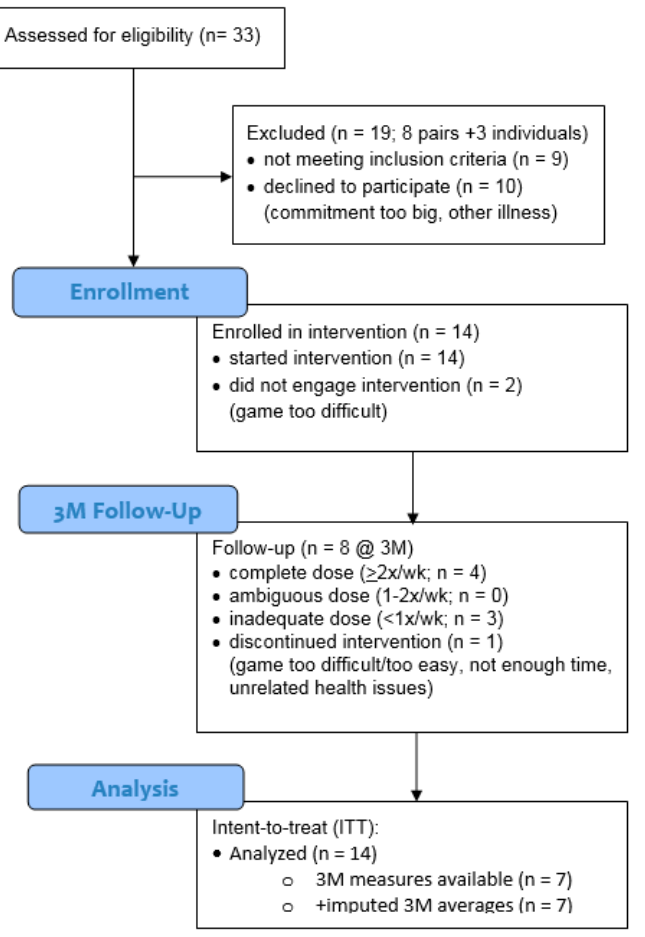
Figure 3. CONSORT Flow Diagram: enrollment and progress of participants through the trial.